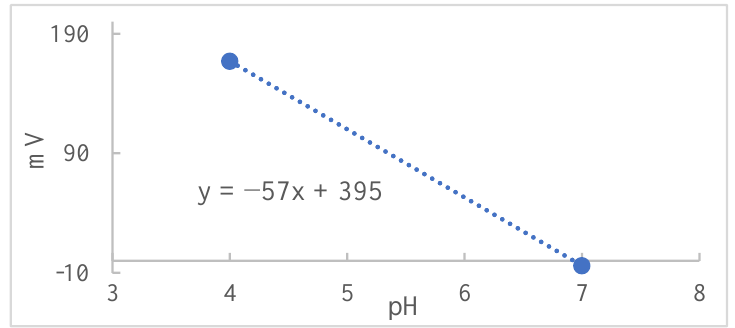
Figure 2. The pH value versus mV obtained by the pH meter calibration system.